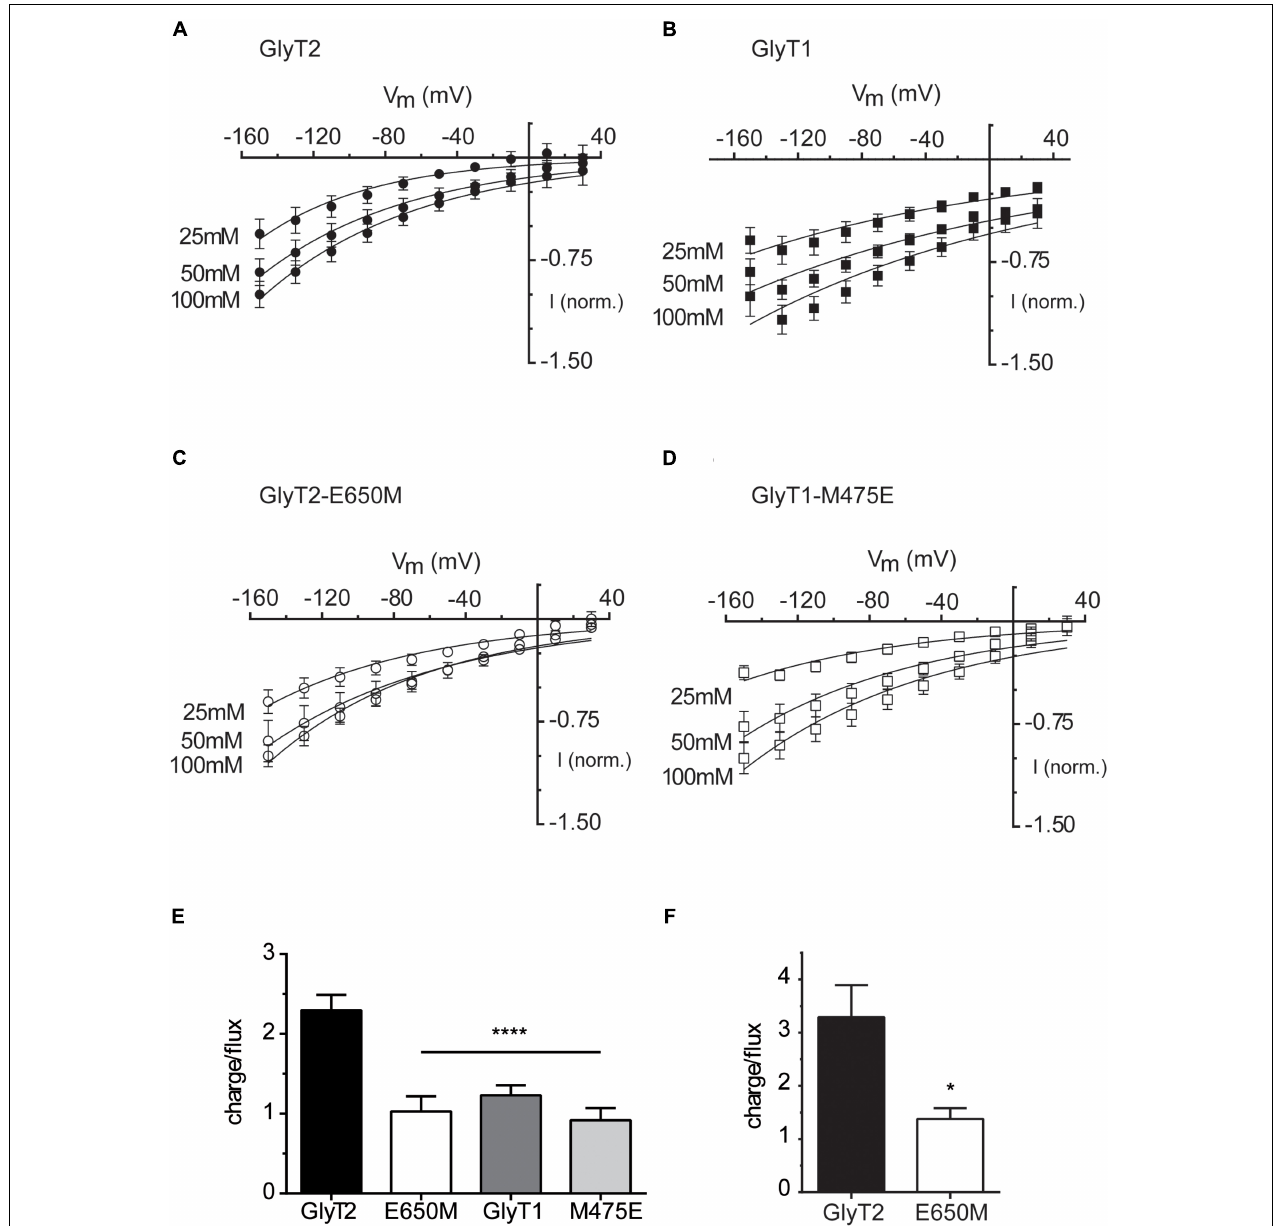
FIGURE 6 | Glycine-induced steady-state currents and charge-to-flux ratios by wild-type GlyTs and mutant transporters. (A–D) Glycine-induced currents: the membrane voltage of oocytes expressing the indicated transporters was stepped from a holding potential of –60 mV to voltages between –150 to 30 mV in –20 mV increments. Currents in 100 mM NaCl recording solution were subtracted from those in the same medium supplemented with 1 mM Gly. At each potential glycine-induced currents were averaged and normalized to those at –150 mV. These currents were then plotted against the corresponding potential (millivolt). The data are the mean ± SEM (error bars) of at least four different oocytes. Wherever error bars are not visible, the error was smaller than the size of the symbols. The mean currents at –150 mV induced by 1 mM glycine were –67.6 ± 6.7 nA in GlyT2, –34.8 ± 2.7 nA in GlyT2-E650M, –132.1 ± 19.2 nA in GlyT1, and –77.6 ± 23.9 in GlyT1-M475E. The rectification degree has been estimated as the ratio of the slopes of the linear regression fit of the three current values at the most negative and most positive potentials in the I/V curves. The calculated rectification degree at 100 mM NaCl are 4 (GlyT2), 1.75 (GlyT2-E650M), 1.3 (GlyT1), and 1 (GlyT1-M475E). (E,F) charge-to-flux ratios: oocytes expressing the indicated transporters were voltage-clamped at –60 mV (E) or –100 mV (F) in 100 mM NaCl recording solution and the current induced by 30 µ M radioactive glycine (0.4 Ci/mmol) was measured for 1 min. The charge moved during this time was obtained by integrating the current over time (Clampfit v. 10.3). The ratio was determined by calculating the moles of charge and dividing by the moles of radiolabeled substrate taken up as determined from scintillation counting after correction by the values for non-injected oocytes. The data are given in mean ± SEM (error bars) of at least four different oocytes. ∗∗∗∗ p < 0.0001 one-way ANOVA with Bonferroni’s multiple comparison test, ∗ p < 0.05 Mann–Whitney test.